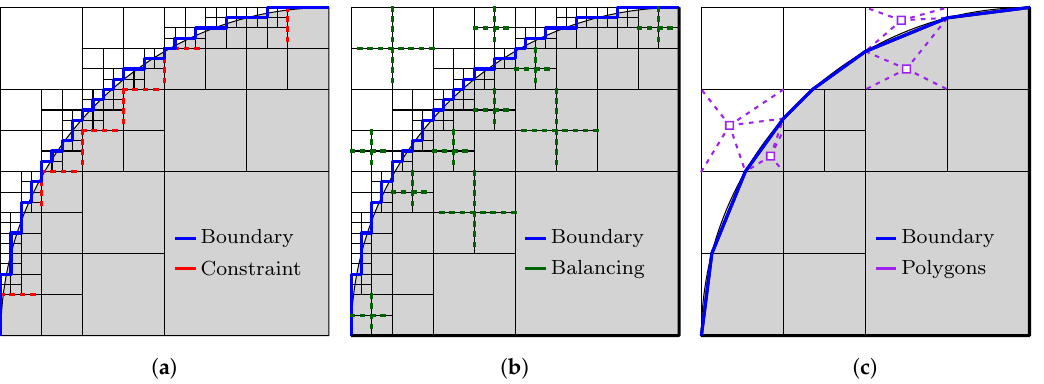
Figure 4. Polygon clipping operating on a balanced quadtree decomposition enables accurate geometry representation with coarser meshes. ( a ) Conventional FEM-based quadtree decomposition; ( b ) Balanced quadtree decomposition; ( c ) Balanced hybrid-polygon quadtree